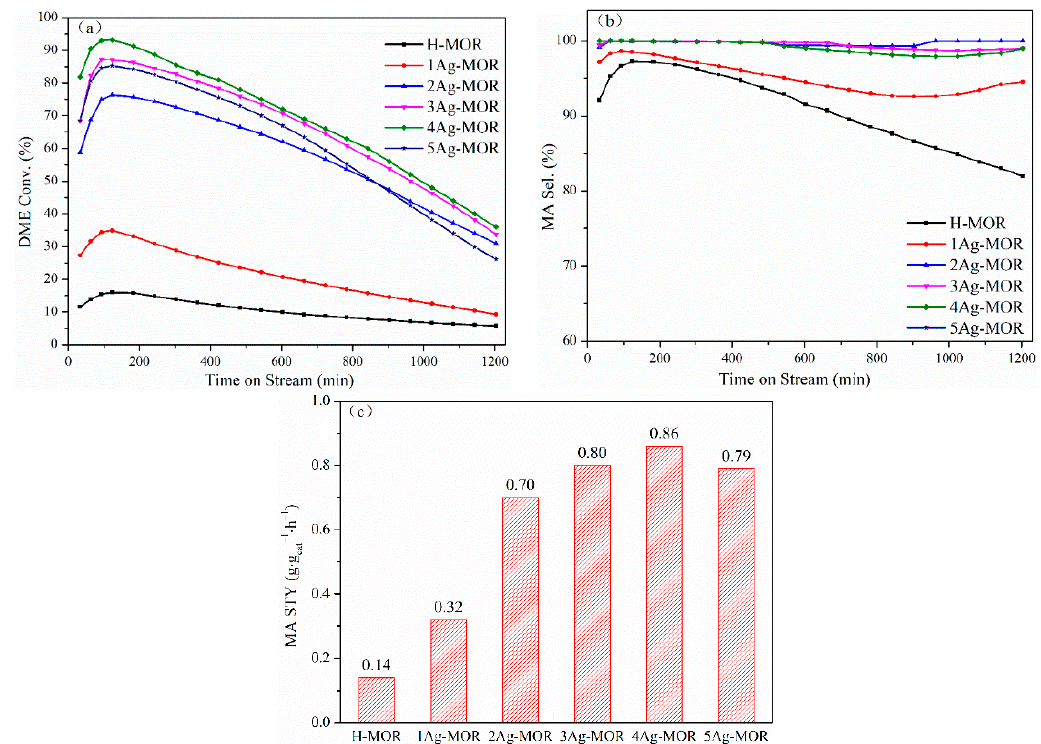
Figure 10. Performances of DME carbonylation over catalysts. ( a ) DME conversion rate during catalyst evaluation; ( b ) MA selectivity during catalyst evaluation; ( c ) MA space ‐ time yield at 120 min.